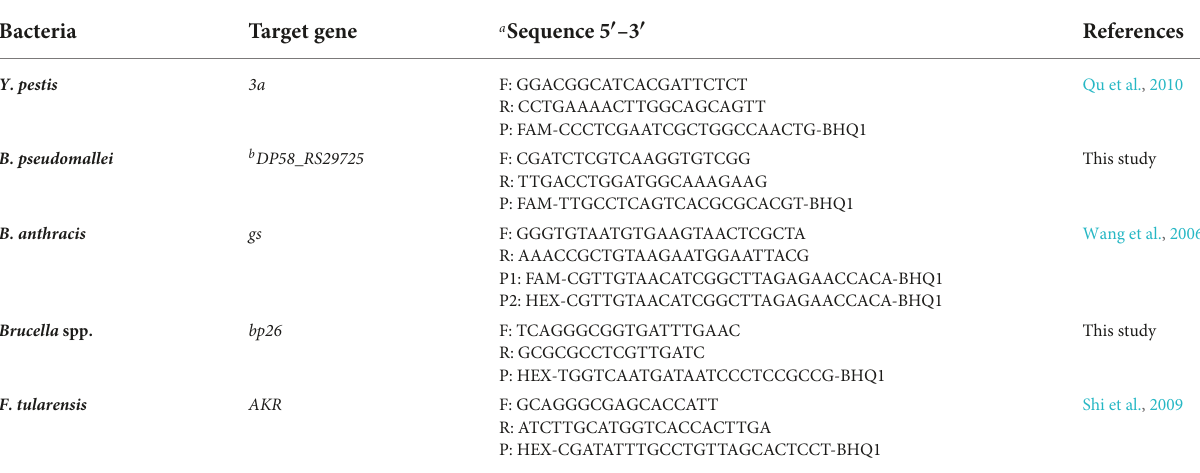
TABLE 1 Primer and probe sequences for the five bacteria